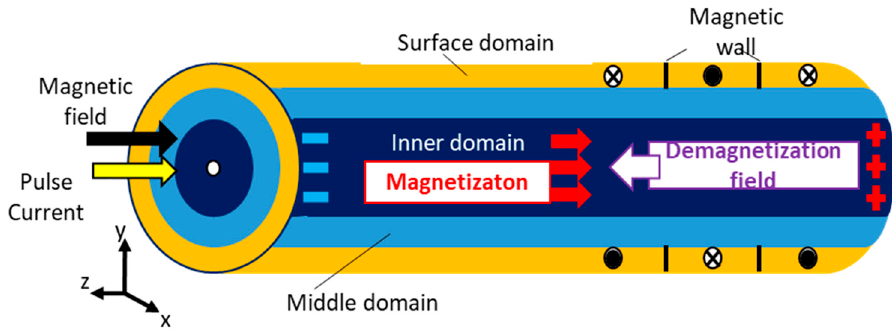
Figure 2. Magnetic domain structures in amorphous wire.